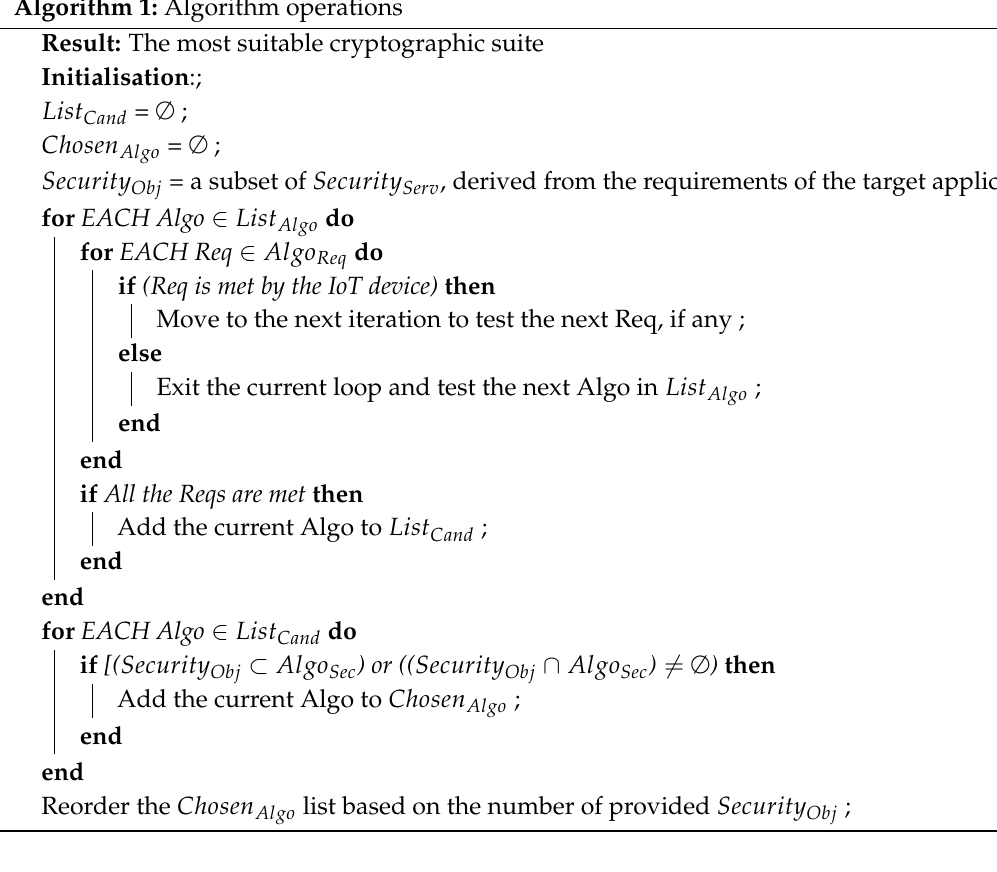
Algorithm 1: Algorithm